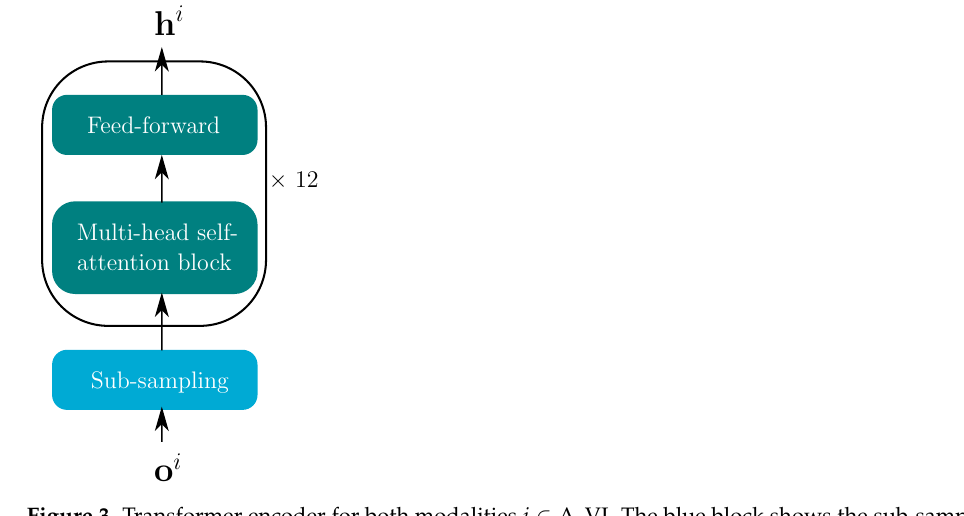
Figure 3. Transformer encoder for both modalities i ∈ A,VI. The blue block shows the sub-sampling, whereas the turquoise blocks comprise the the transformer